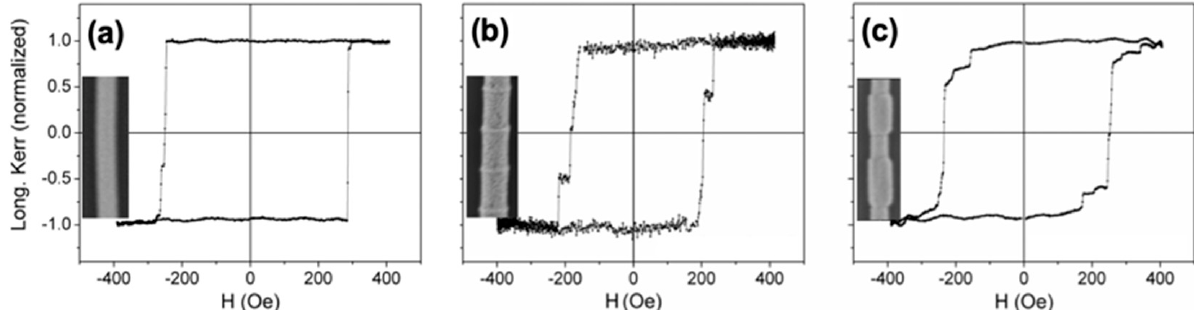
Figure 7. Magneto-Optical Kerr Effect (MOKE) hysteresis loops for uniform diameter ( a ) bamboo-type ( b ) and modulated diameter ( c ) nanowires. The insets show the SEM images of individual nanowires. Adapted with permission from ref. [19]. Copyright 2015 IOP Publishing Ltd.